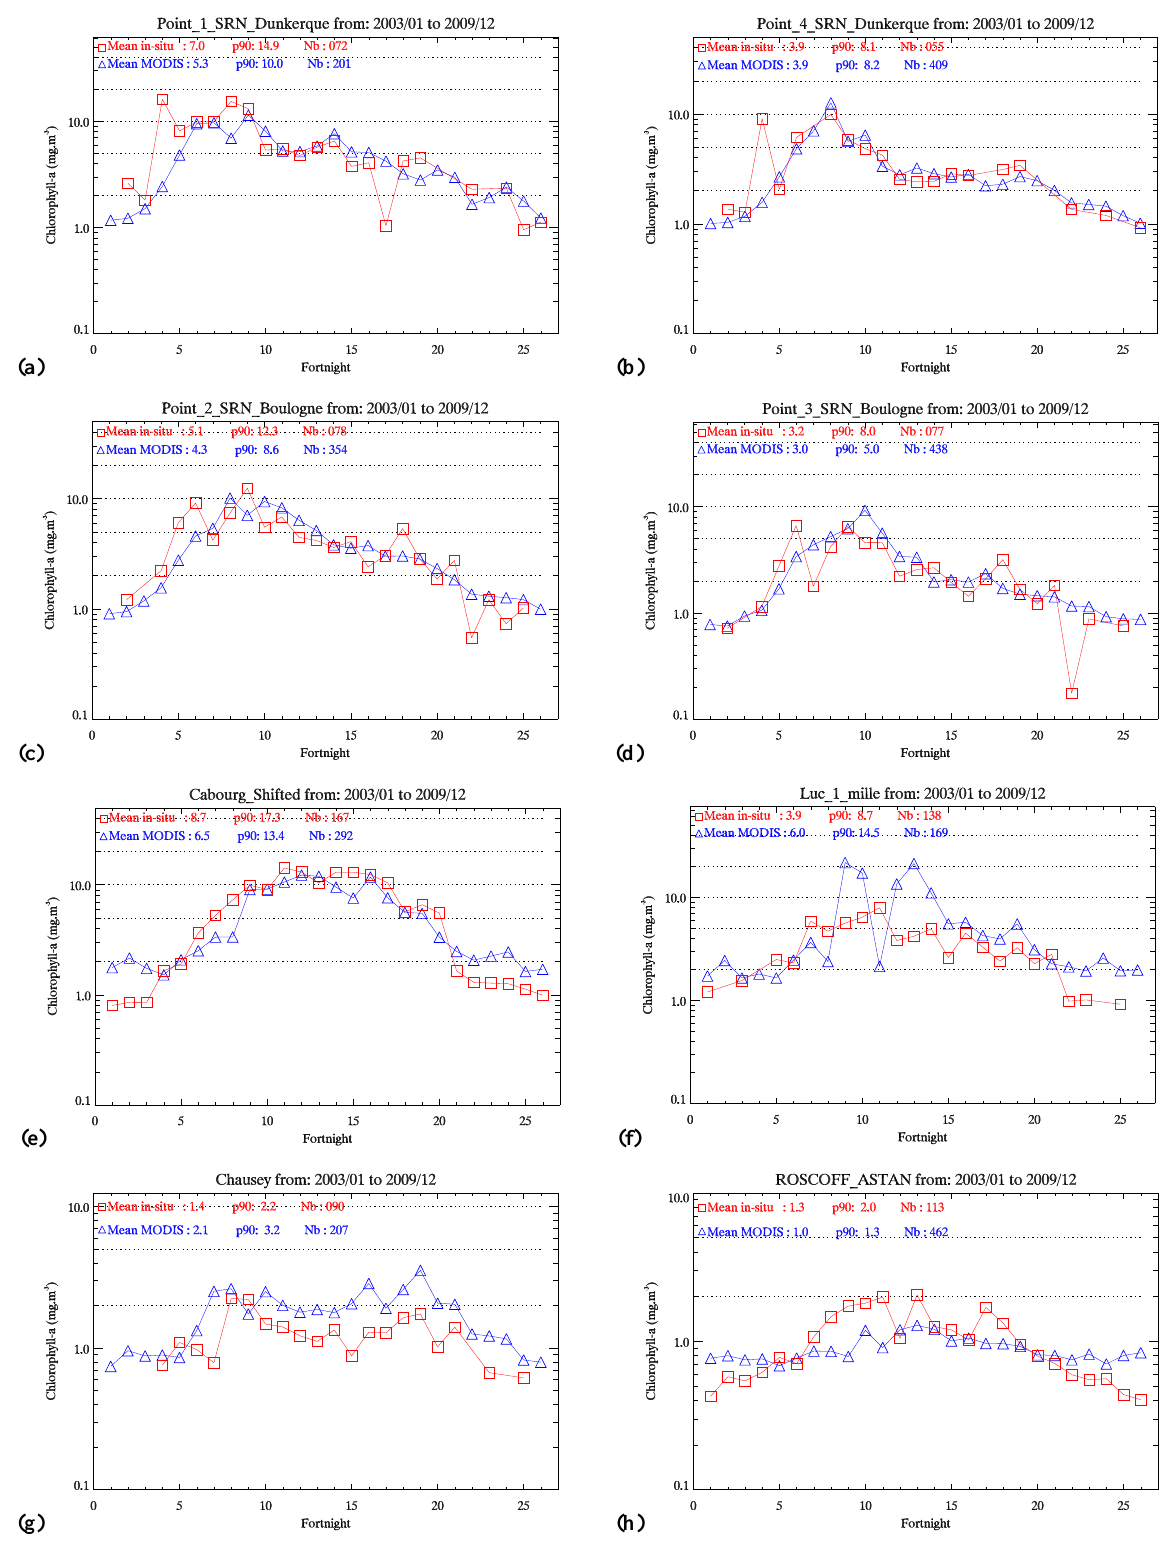
Fig. 3. The annual cycles of chlorophyll at some selected stations from the North Sea to Northern Brittany. Statistics indicated on the graphs (mean, p90, Nb samples available) concern the productive season (March to October). For the SRN transects off Dunkerque, Point 1 is coastal and Point 4 the furthest offshore. Same for Boulogne with Point 3 the farthest